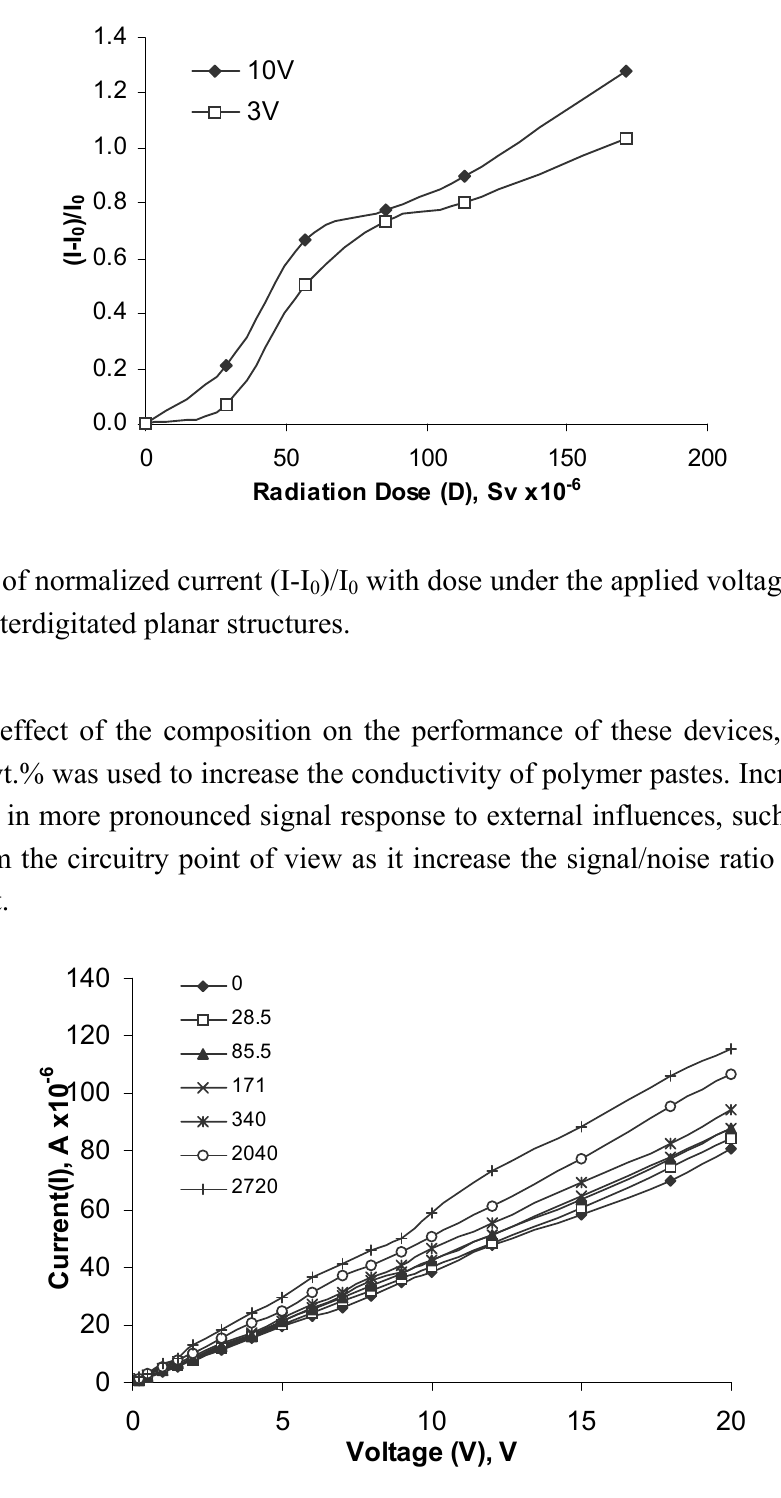
Figure 8. I-V plots of as-printed and γ -irradiated NiO planar structures doped with 0.1 wt.% of